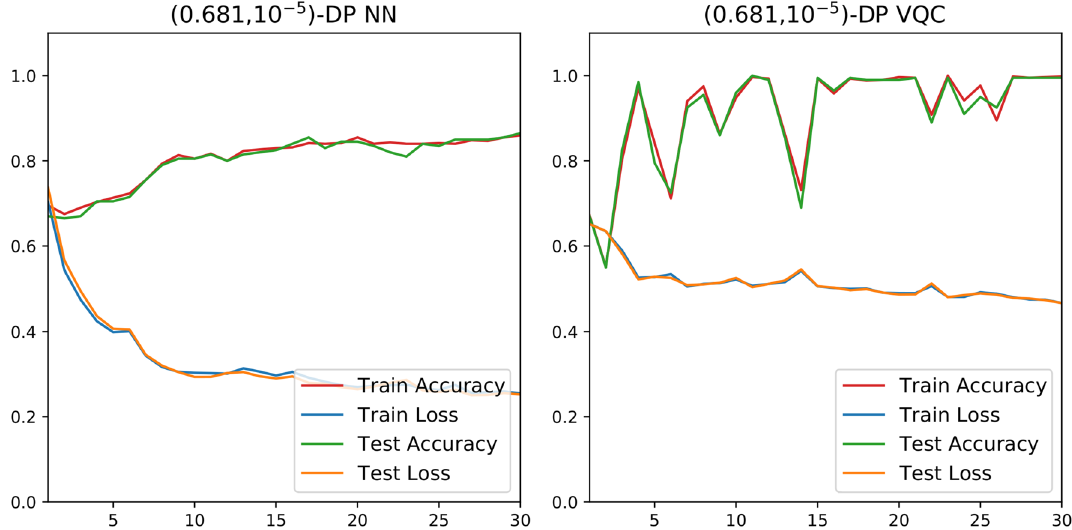
Figure 8. Results for differentially private NN and variational quantum classifier of “circles” with 1000 samples, a learning rate of 0.05, and RMSprop